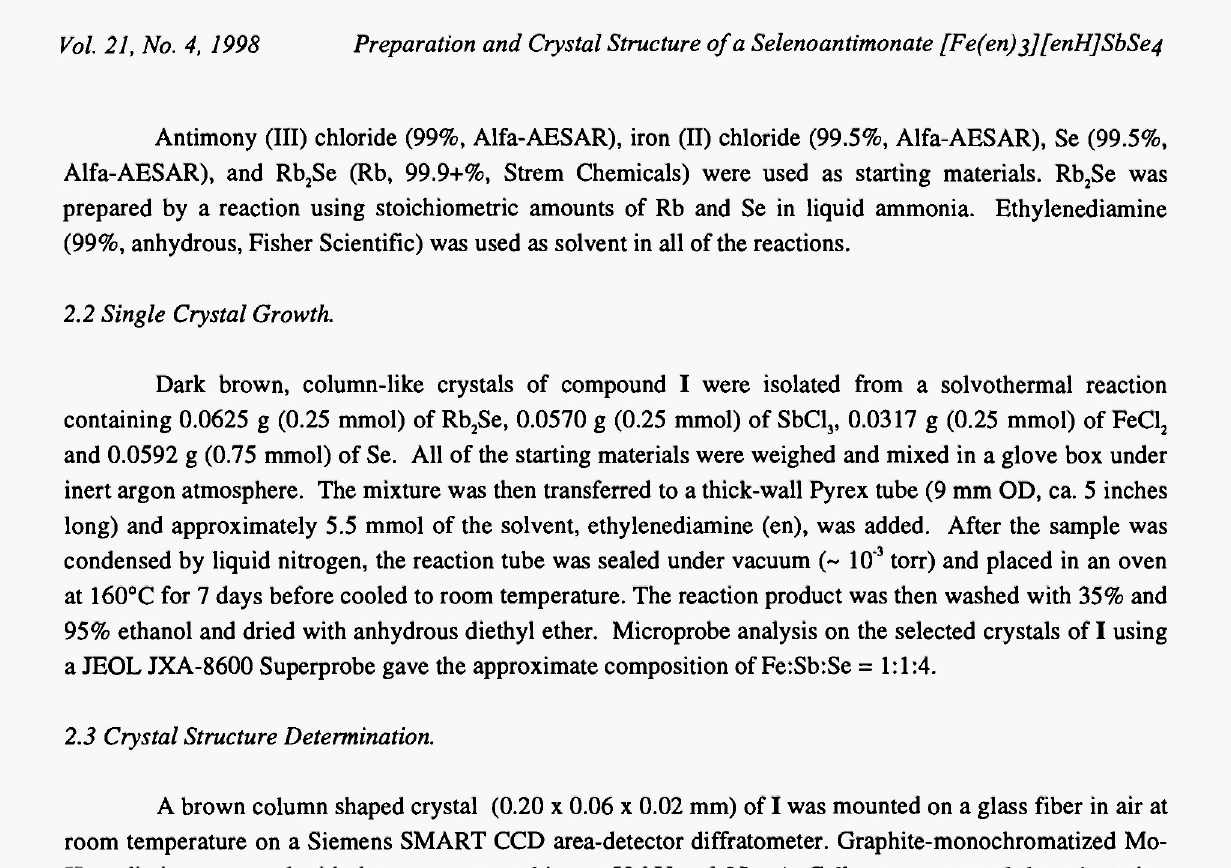
Table I. Crystallographic Data for [Fe(en)